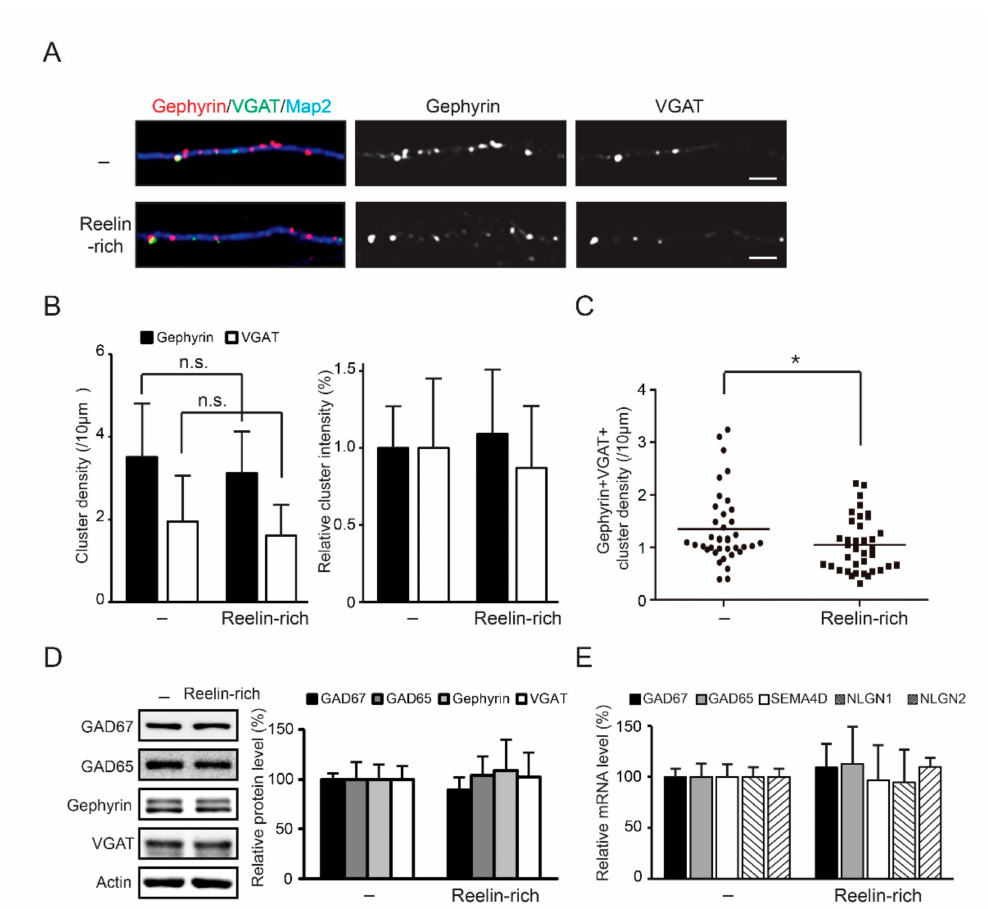
Figure 4. Reduced density of inhibitory synapses by Reelin-rich protein supplementation without changes in expression of inhibitory synapse-related proteins. ( A ) Twelve-day in vitro hippocampal neurons were supplemented with Reelin-rich protein for 12 h and imaged using immunofluorescence followed by confocal microscopy. Gephyrin-positive or VGAT-positive clusters were seen on the dendrites of Map2-positive excitatory neurons. ( B , C ) The numbers and fluorescence intensity levels of synaptic gephyrin-positive or VGAT-positive clusters were quantified and the sample distribution of both gephyrin- and VGAT-positive clusters is shown. Each density of gephyrin- or VGAT-positive clusters did not change, but the density of both gephyrin- and VGAT-positive clusters decreased significantly. The results (number of dendritic fields = 37–39) were analyzed using the Mann–Whitney U test. ( D ) Twelve-day in vitro cortical neurons were treated with Reelin-rich protein for 12 h and assayed using Western blot analysis. The expression levels of inhibitory synapse-related proteins were not changed in response to Reelin-rich protein supplementation. The results were averaged from four individual experiments. ( E ) Twelve-day in vitro cortical neurons were treated with Reelin- rich protein for 3 h and mRNA contents were quantified using quantitative real time-PCR. The transcripts levels of inhibitory synapse-related genes were not changed in response to Reelin-rich protein supplementation. The results were analyzed using the Mann–Whitney U test. Note: * p < 0.05 and n.s., nonsignificant. Scale bars, 5 µ